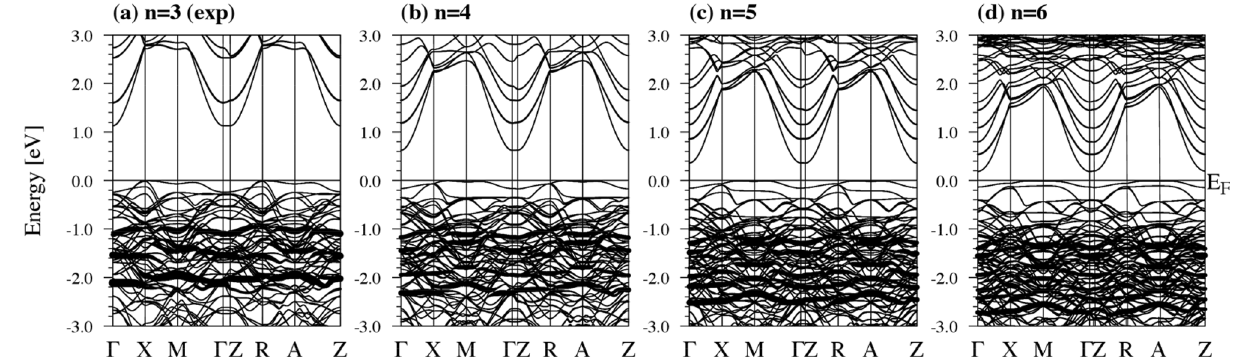
3 6 reduced nickelates at d 9 filling using GGA+ U ( U = 5 eV) with Figure 2. Band structures for La-based n = − 3 , La 5 Ni 4 O 10 = 5410, n 4 , La 6 Ni 5 O 12 = 6512, n 5 , and La 7 Ni 6 O 14 = 7614, AF ordering (La 4 Ni 3 O 8 = 438, n = = = 6 ). ( a ) For the n 3 material, the energy gap is 1.13 eV. ( b ) For n 4 , the energy gap is 0.63 eV. ( c ) For n = = = 5 , the energy gap is 0.35 eV. ( d ) For n 6 , the energy gap is 0.19 eV. The majority d n z 2 orbital of all Ni atoms = = is highlighted in the band structure.